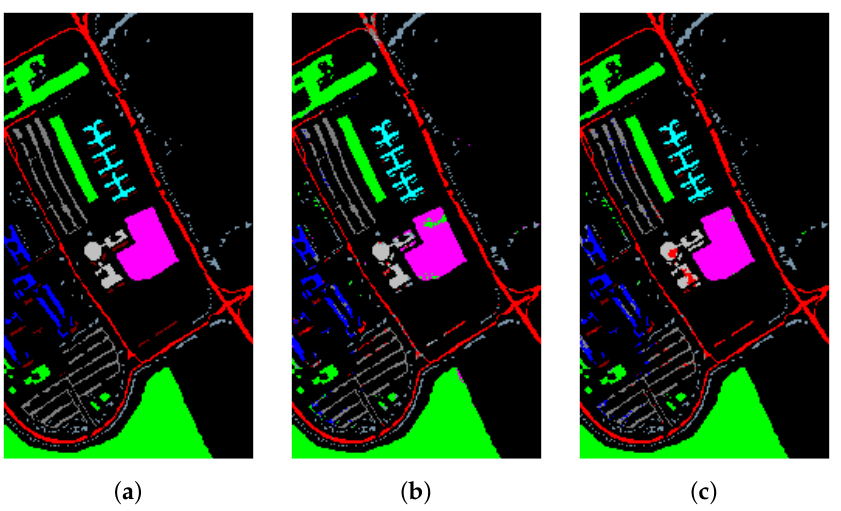
Figure 17. The classification maps of University of Pavia. ( a ) Ground-truth map. ( b ) Classification results of the Transformer without metric learning. ( c ) Classification results of the Transformer with metric learning.